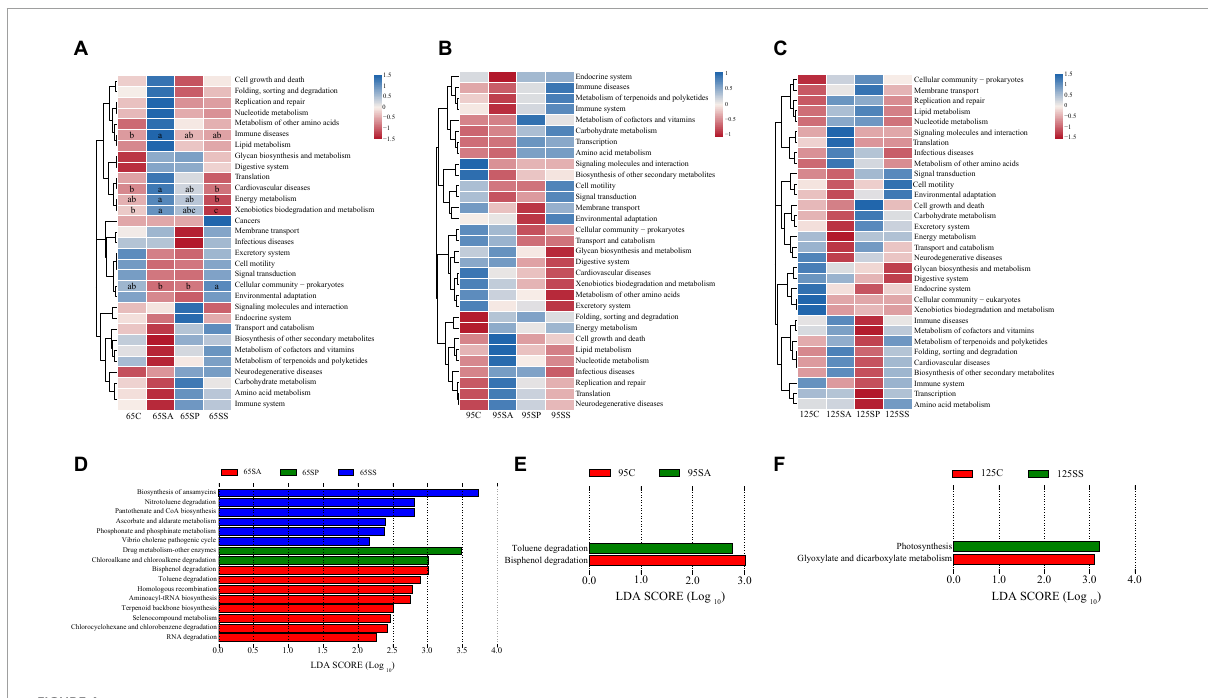
FIGURE4 Predicted function of colonic microbiota of offspring pigs between the experimental groups and the control group. The heatmap showed that the comparisons of microbiota pathways among different treatment groups at 65 (A) , 95 (B) , and 125 (C) days of age at level 2 using Kruskal-Wallis test. The LEfSe histogram showed that the different metabolic pathways among different groups at 65 (D) , 95 (E) , and 125 (F) days of age at level 3. Different lowercase letters in the same row were significantly different ( P < 0.05). 65C, 95C, and 125C, sow fed with basal diet; 65SA, 95SA, and 125SA, sow fed with antibiotic; 65SP, 95SP, and 125SP, sow fed with probiotics; 65SS, 95SS, and 125SS, sow fed with synbiotics.